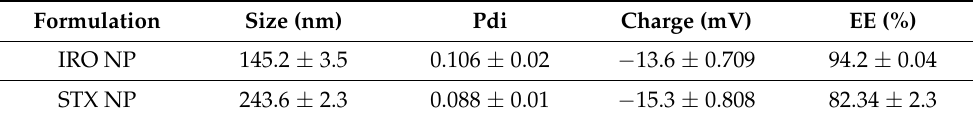
Table 1. Characteristics of synthesized IRO and STX nanoparticles (NP).